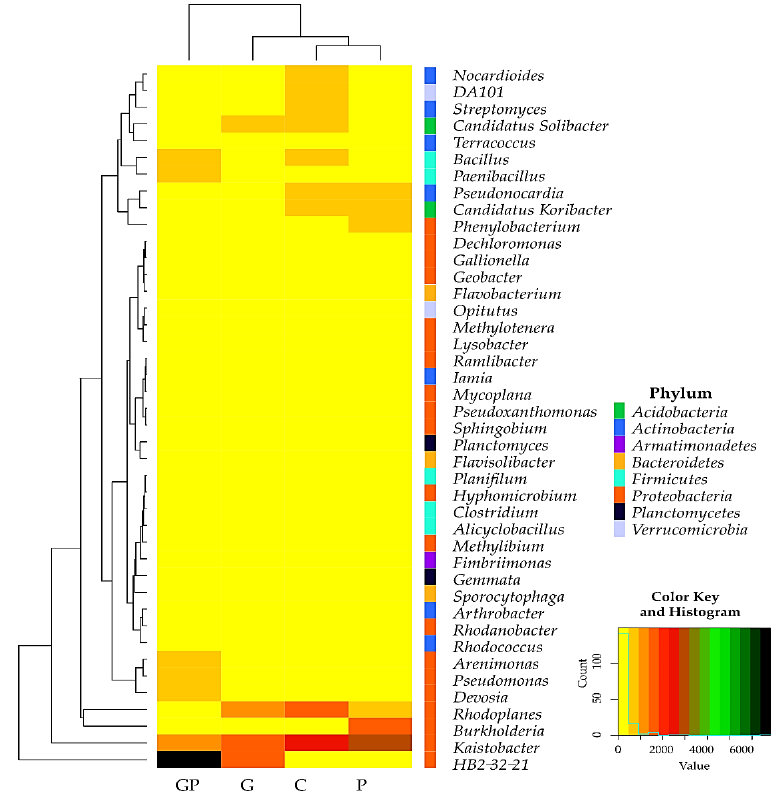
Figure 4. Number of OTU ≥ 1% of 42 bacterial genera in the soil presented using the heat map with classification to the phylum. C — non-polluted and non-sown soil, G — non-polluted soil sown with cocksfoot, P — non-sown soil polluted with petrol, and GP — soil polluted with petrol and sown with cocksfoot.